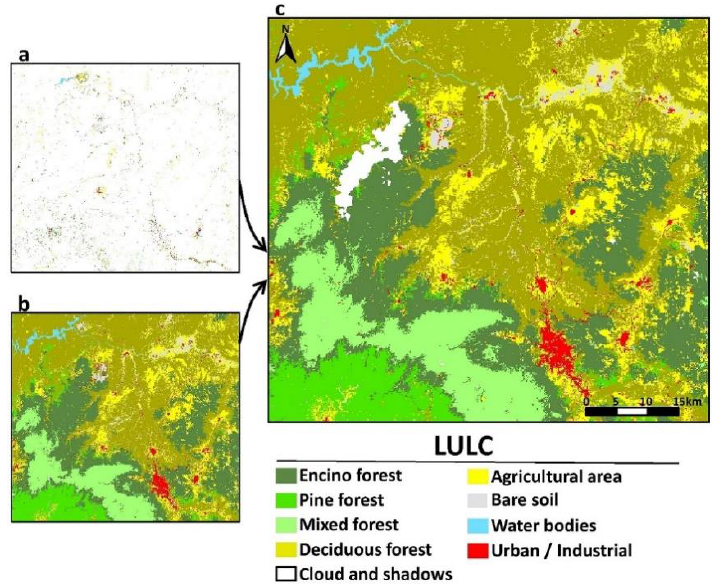
Figure 10. Integration of the test date LULC map. ( a ) Classification of changed pixels, ( b ) base date LULC map, ( c ) test date LULC final map, supplemented and corrected for the salt-and-pepper effect.